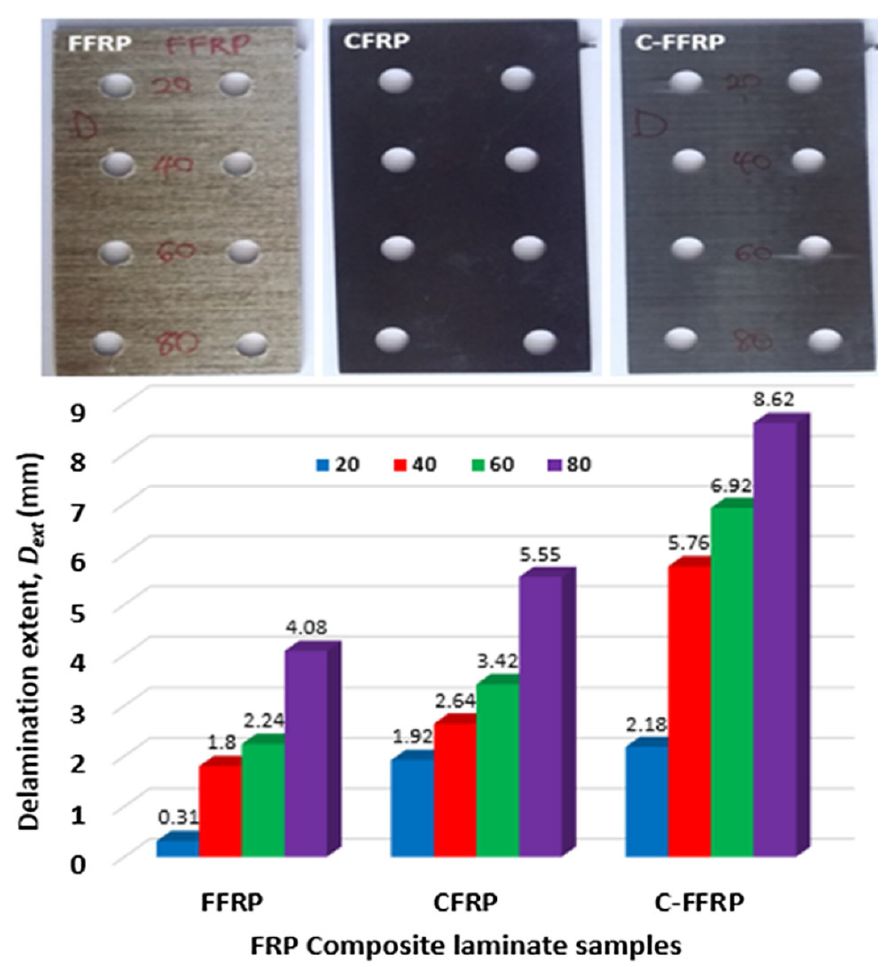
Figure 10. The influence of traverse speed ( Ts ) on delamination damage [19].